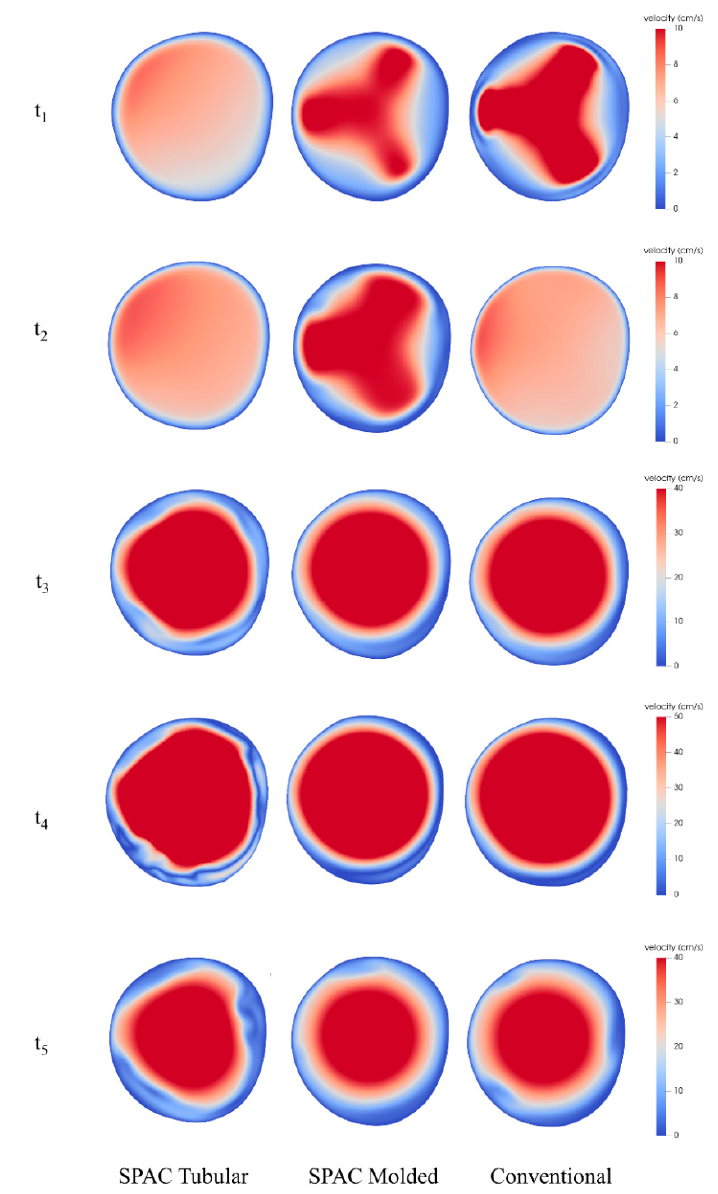
Figure 7. In-plane velocity distribution in slice 1 at the acceleration peak.